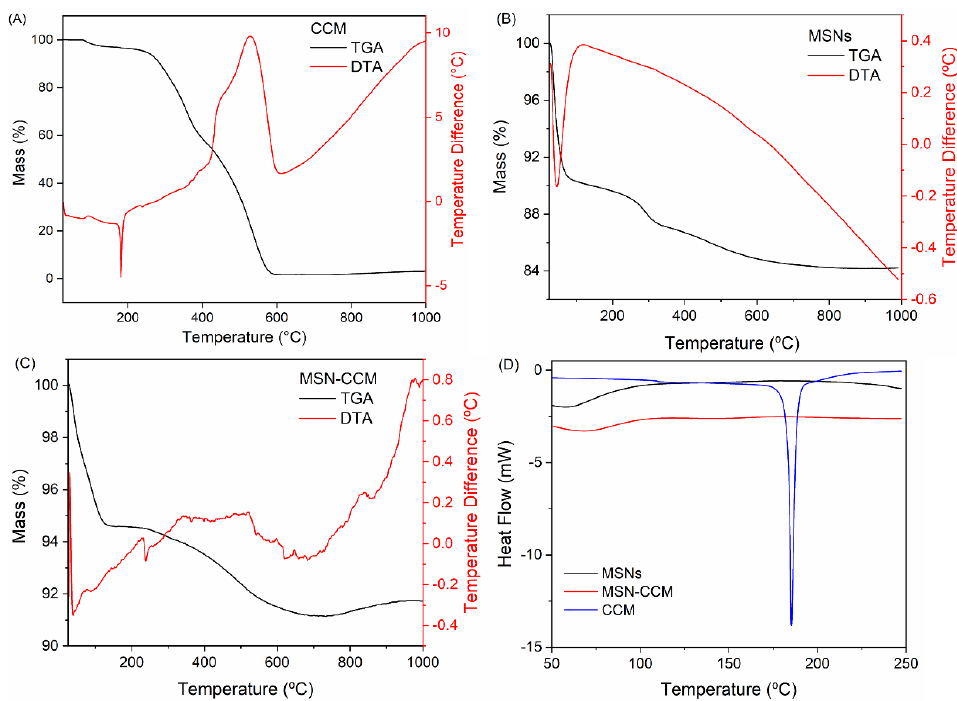
Figure 4. TGA/DTA curves of the ( A ) CCM, ( B ) NSMs, and ( C ) MSN-CCM; ( D ) DSC curves of the CCM, MSNs, and MSN-CCM (blue, black, and red lines, respectively).